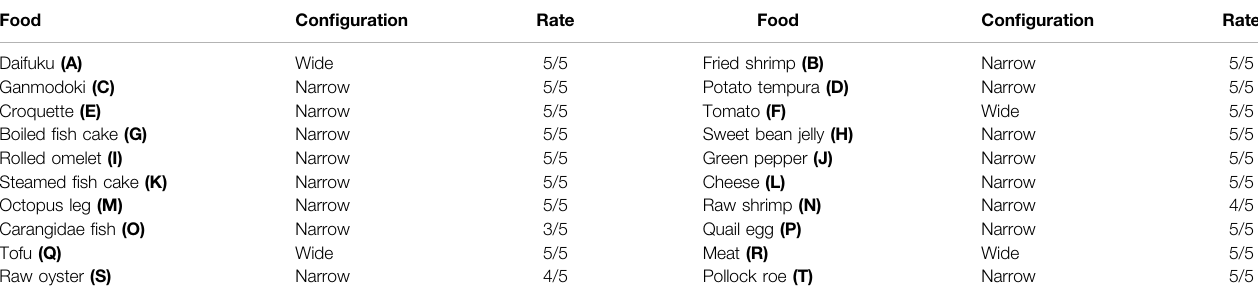
TABLE3| Successrate(numberofsucceededtrials/totaltrialnumber)ofthehandlingtests,where “ Wide ” and “ Narrow ” denotedifferentgrippercon fi gurations.Boldletters of A, B, C, ... correspond to the food item labels in Figure 9